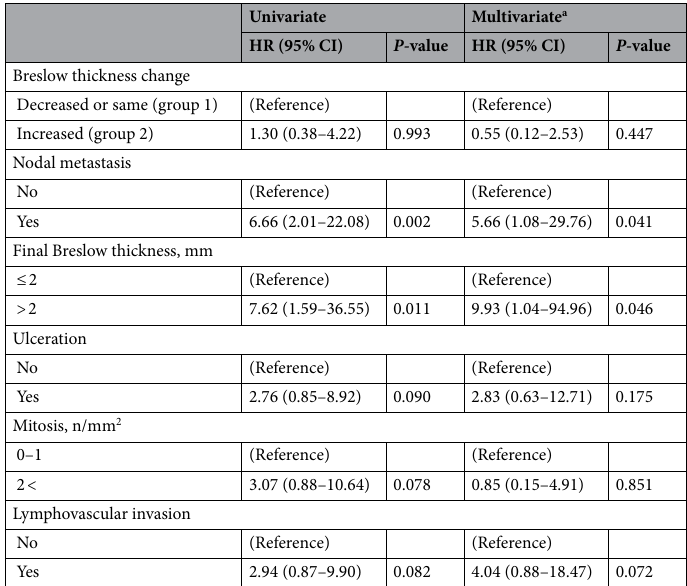
Table 2. Cox models for melanoma-specific survival in relation to changes in Breslow thickness between the initial punch biopsy and final excision specimens. CI confidence interval, HR hazard ratio. Among all covariates in Table 1, variables with P -values less than 0.1 in univariate Cox analysis were listed (except for changes in Breslow thickness) and included (with age and sex) in multivariate analysis. a Multivariate Cox analysis was performed using age, sex, and all variables in the list.